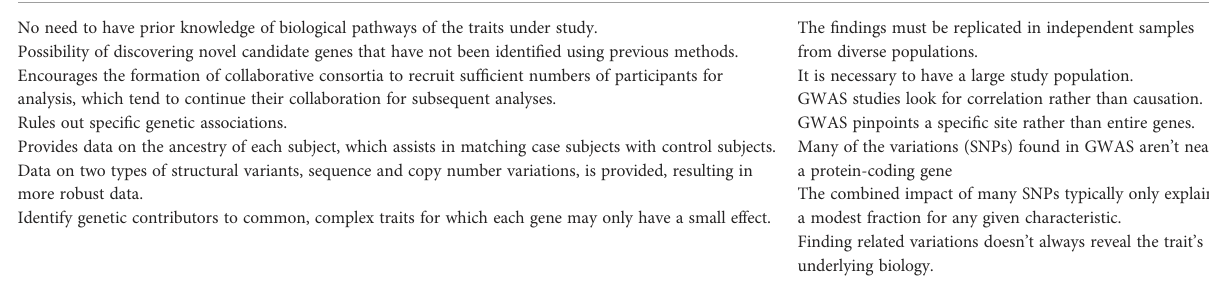
TABLE 2 A comparison of GWAS bene fi ts and